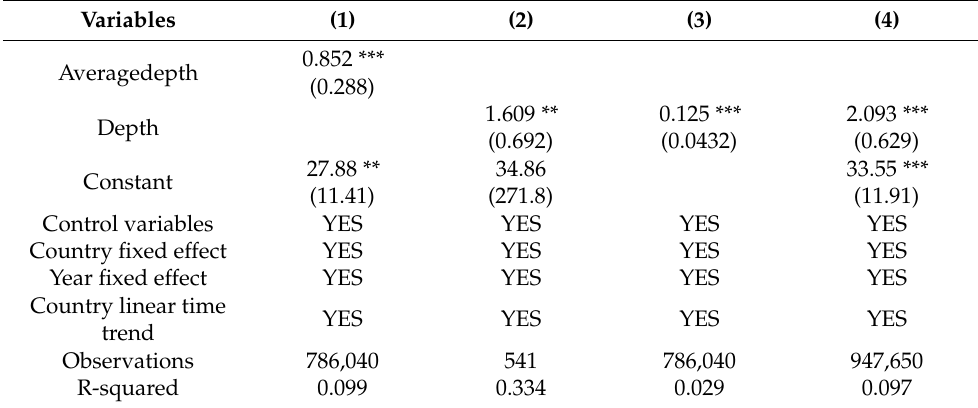
Table 5. Robustness test